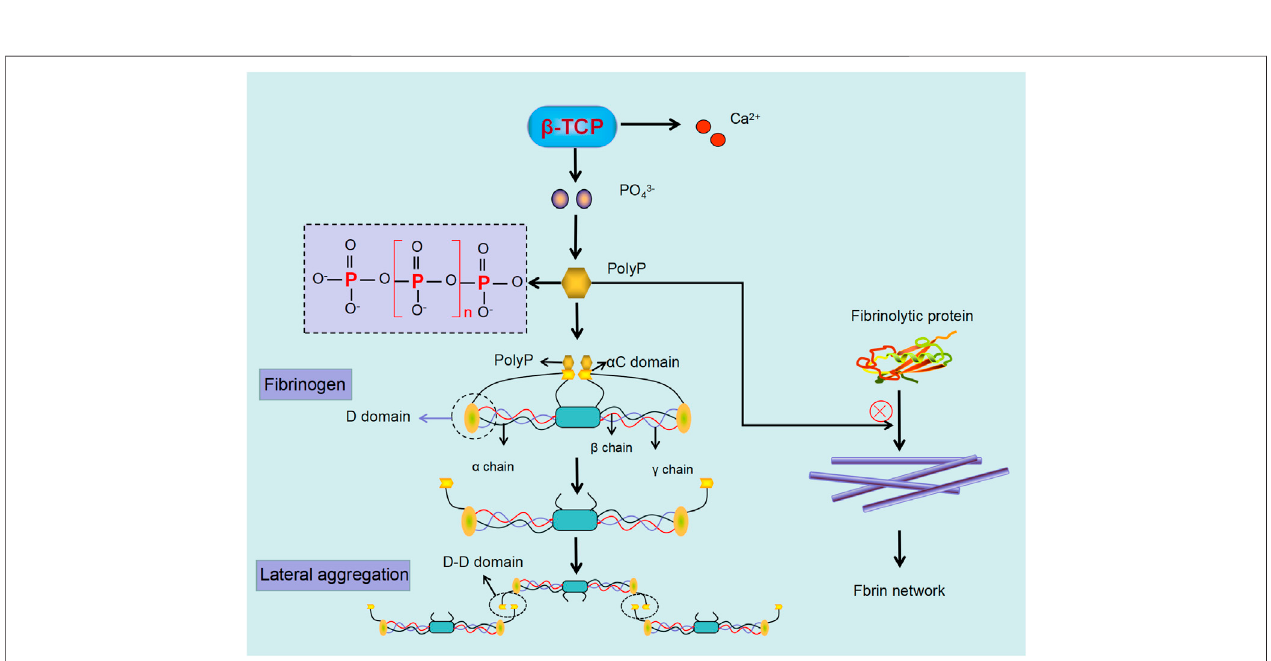
FIGURE6| Phosphateions(PO 43 − )releasedfrom β -TCPcanpolymerize toform PolyP,whichregulate fi brinpolymerizationandenhanceresistanceto fi brinolysis. PolyPbindingto α Cregionin fi brinogenresultsinextensionbeyondtheD-region,withsubsequentD-Dinteraction,resultinginlateralaggregationof fi brin.Moreover,the formed PolyP can further defend fi brinolytic protein from linking to the fi brin, leading to dense and undissolved fi brin.